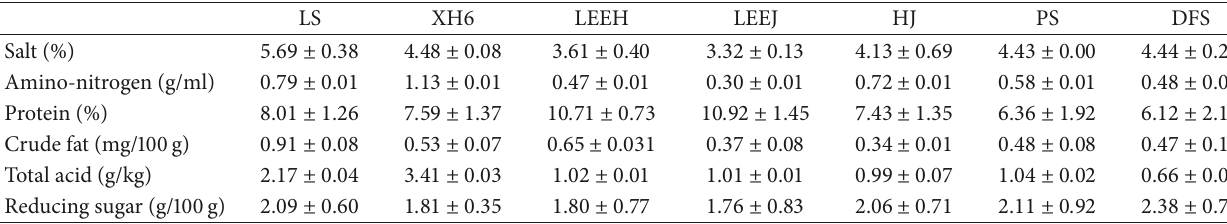
Table 1: Basic compositions of SFFPs (mean ± Std., 𝑛 = 2